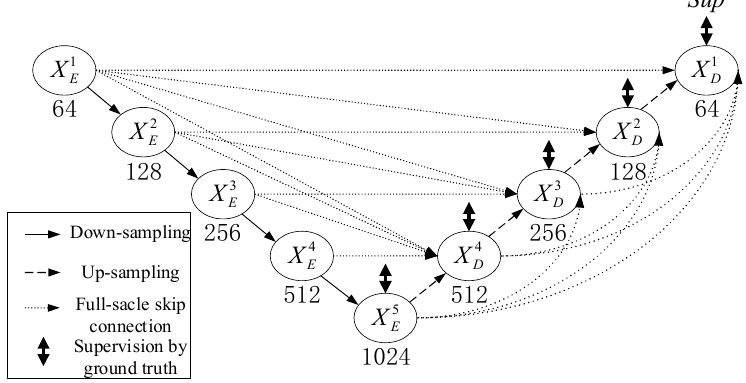
Figure 1. The network architecture of